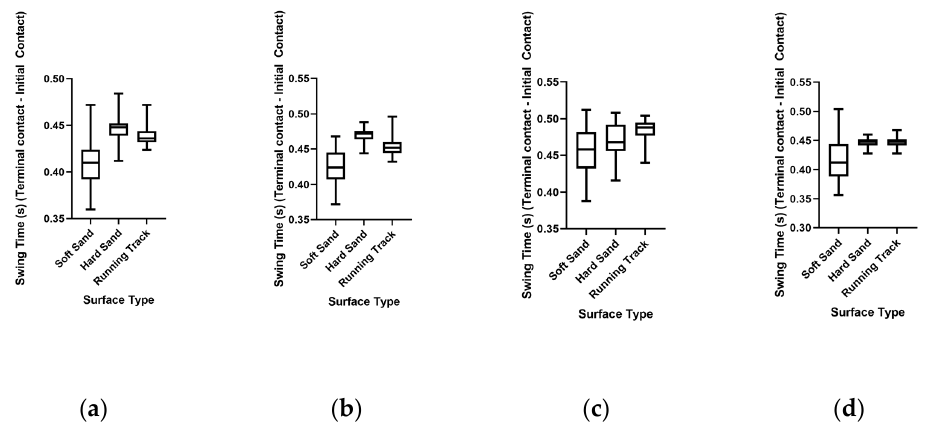
Figure 3. Box and whisker plot showing gait swing time for each surface type for participants 1–4 ( a – d ). Note the much larger variability during soft sand running.